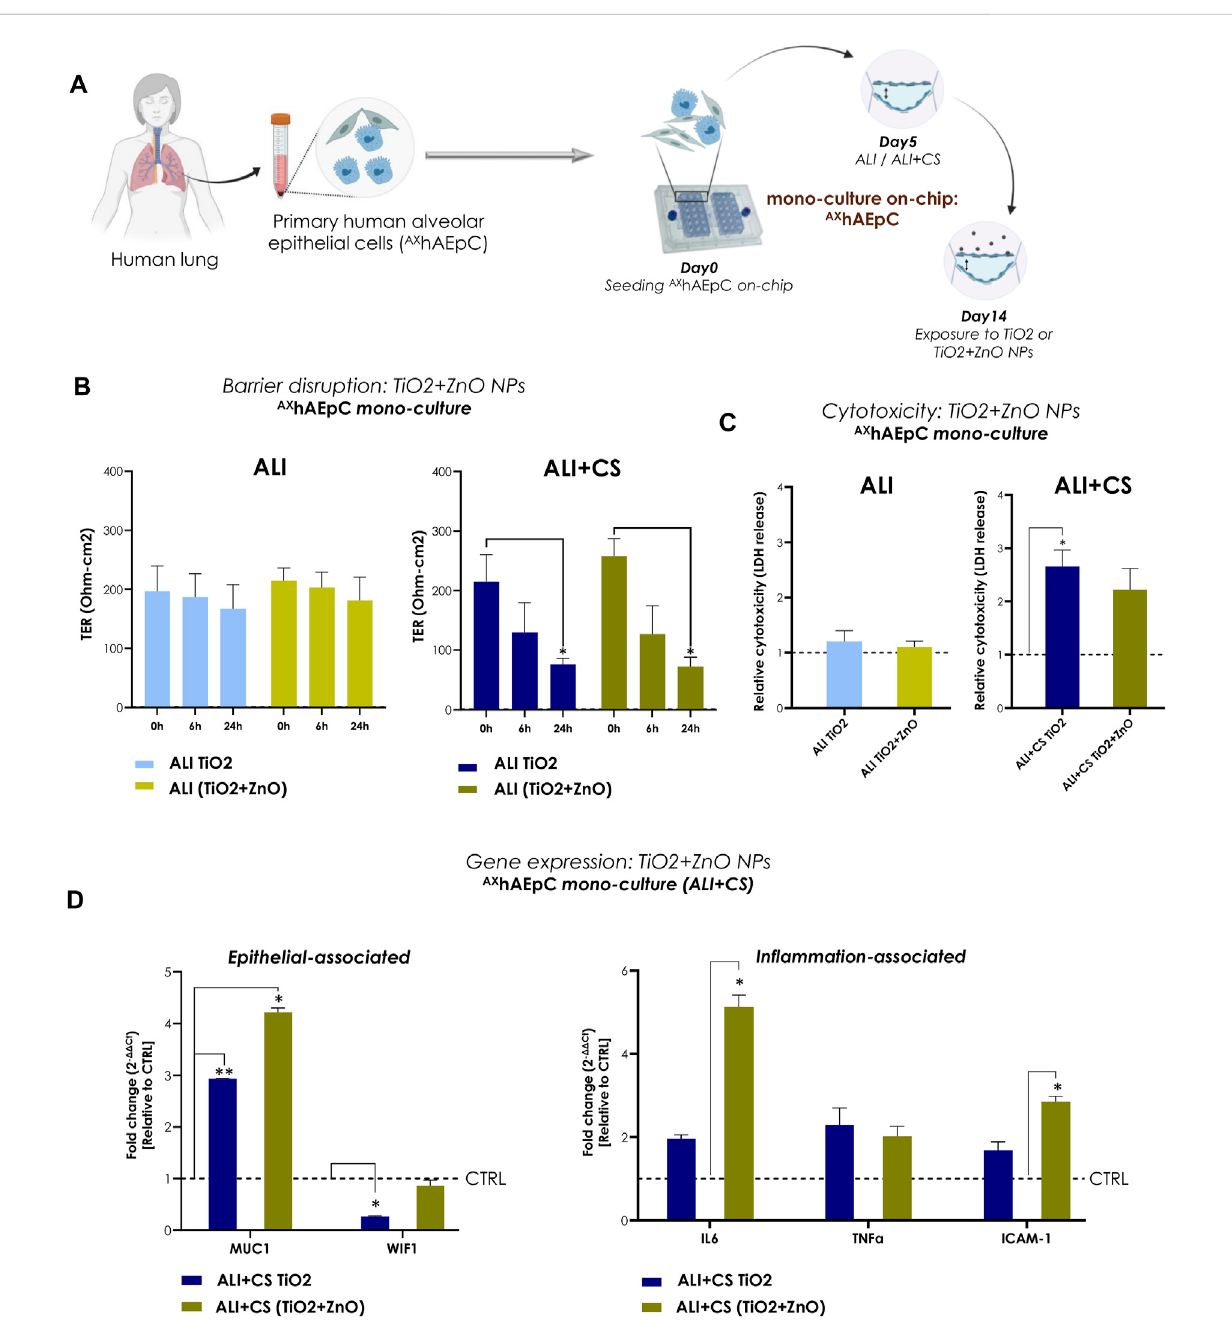
FIGURE 5 NPs-induced in fl ammation in primary human alveolar epithelial cells ( AX hAEpC) on-chip (A) A schematic representation AX hAEpCs seeded in the AX12 plate. The timeline shows the cell culture and NP exposure process on-chip. (B) TER values (Ohm-cm2) were recorded before NPs nebulization (at 0 h) and at 6h and 24 h after TiO2 and TiO2+ZnO mixed NPs exposure (N = 2; n = 6). The signi fi cance of exposure at 6h and 24 h was measured compared with thevalues at0 h. (C) Thelevels ofLDH at24 hwerenormalizedusinguntreatedcontrol samples(ALIandALI + CS)(N= 2,n= 4). (D) Gene expression was analyzed 24 h after NPs exposure using mRNA harvested from ALI + CS cell cultures. The fold change values were normalized to healthy controls (N = 2, n = 4). Data are shown as mean ±